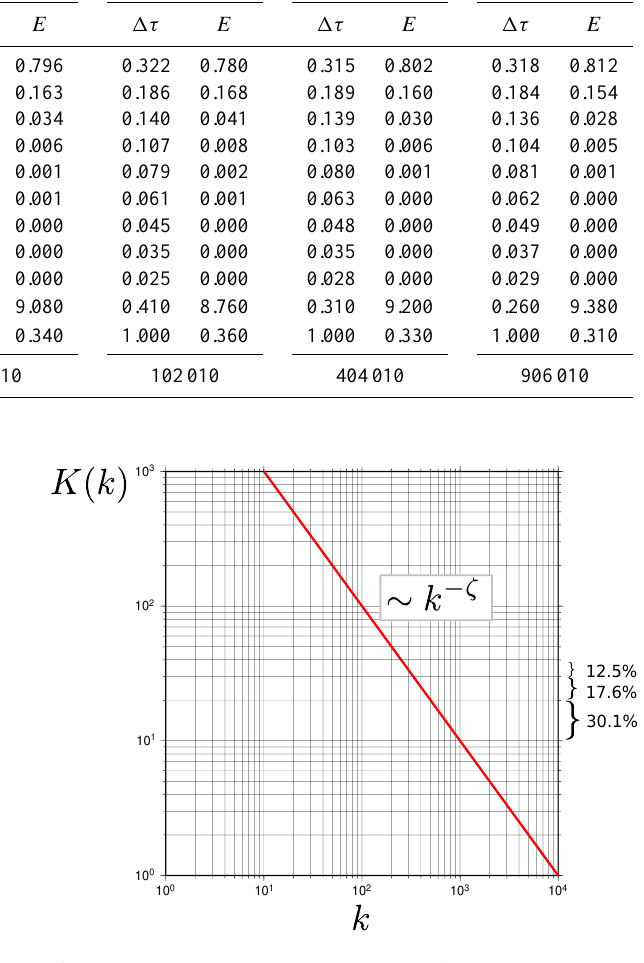
Figure 6. Theoretical power law behavior of a natural